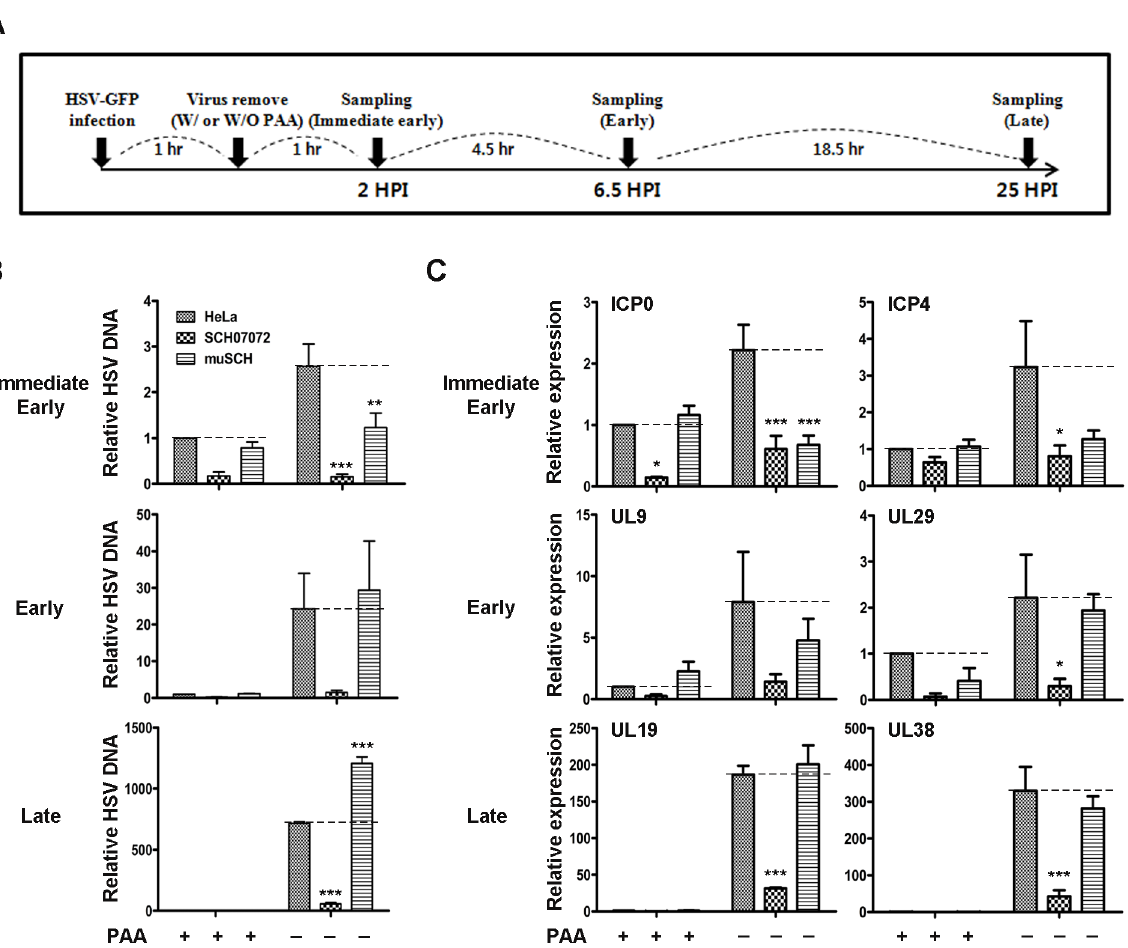
Figure 5. 3D8 scFv inhibits HSV-1 encoded gene expression by DNase and RNase activity. A . Schematic diagram for identification of viral gene expression pattern by HSV-1 challenging. B . Wild-type HeLa, SCH07072, and muSCH cells were infected with HSV::GFV at an MOI of 0.5 and then incubated for 2, 6.5, and 25 hr in the presence or absence of PAA 1 hr after virus challenge. ICP4 was used for the immediate early stage, UL9 for the early stage, and UL19 for the late stage of viral infection. Data bars show mean 6 standard error. ** and *** indicate significant differences from HSV-1 viral DNA at p , 0.01 and p , 0.001 , respectively (one-way analysis of variance and Tukey’s post hoc t -test). C . Quantitative real-time reverse transcription-polymerase chain reaction (RT-PCR) was used to measure the expression of immediate early genes (ICP0 and ICP4), early genes (UL9 and UL29), and late genes (UL19 and UL38). The relative concentrations of HSV mRNAs were calculated after normalization to the GAPDH gene using the delta delta C T method. Data bars represent mean 6 standard error. *, **, *** indicate significant differences from HeLa cells at p , 0.05, p , 0.01 , and p , 0.001 , respectively (one-way analysis of variance and Tukey’s post hoc t